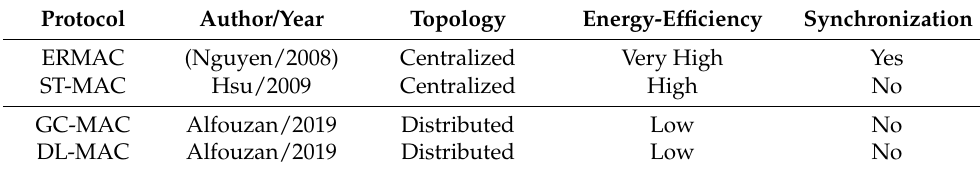
Table 4. Summary of TDMA-based energy-efficient MAC protocols for